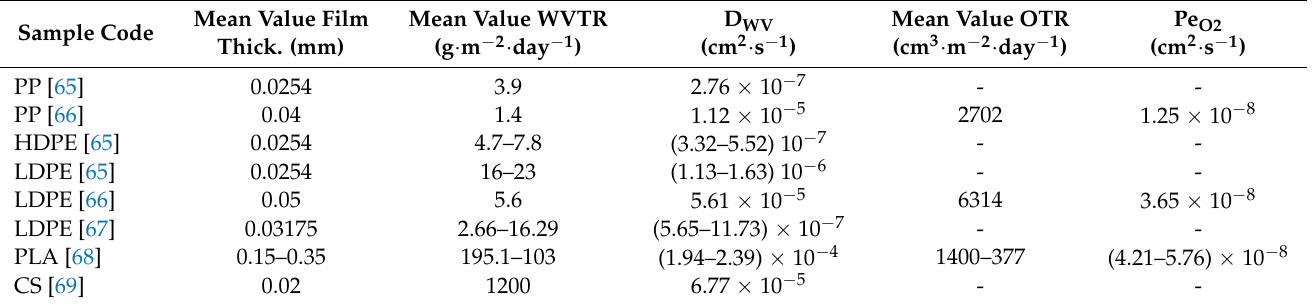
Table 4. Calculated D WV and Pe O2 values based on WVTR and OTR measurements of previously reported polymer films.